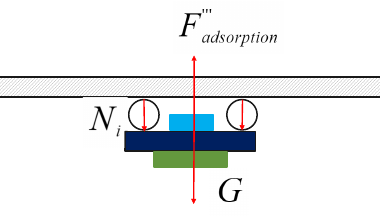
Figure 4. Schematic diagram of the static analysis under State